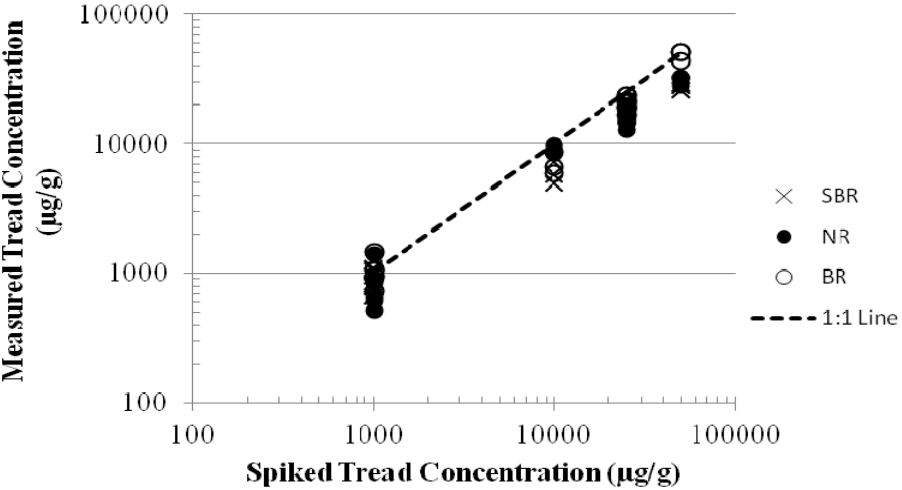
Figure 1. Measured and actual tread polymer concentrations based on pyr-GC/MS analysis of blinded artificial soil samples. Markers are styrene (SBR), butadiene (BR), and isoprene (NR or